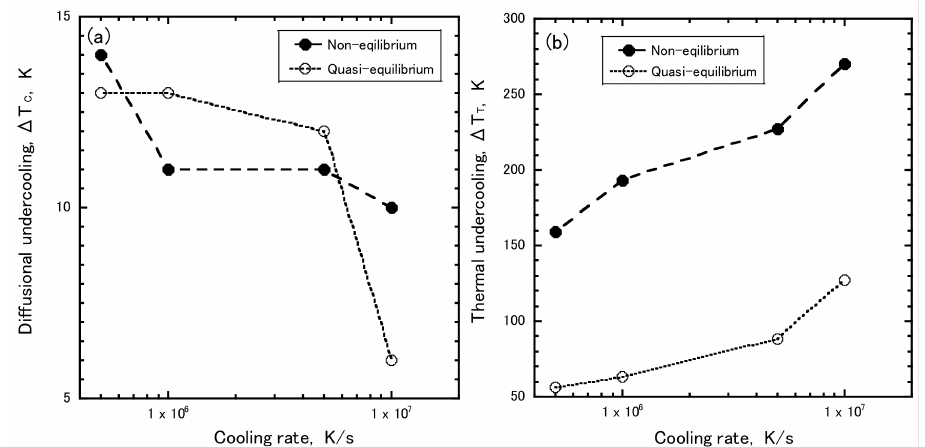
Figure 12. Undercooling with cooling rate: ( a ) diffusional undercooling; ( b ) thermal undercooling.